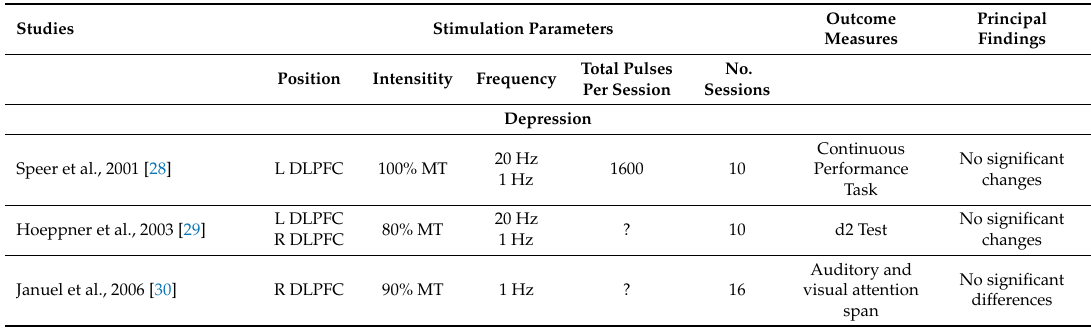
Table 2. Description of the repetitive transcranial magnetic stimulation (rTMS) interventions in the included